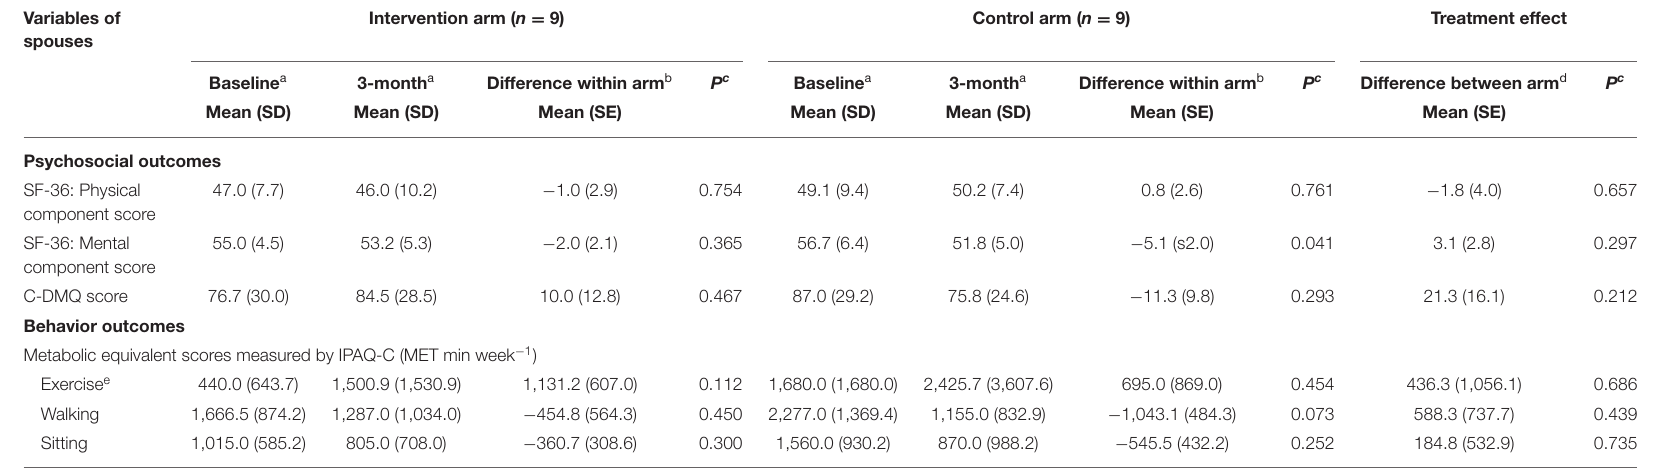
TABLE 3 | Treatment effects of couple-based interventions on spouses of the 3-month pilot study (couple pair N = 18). Variables of